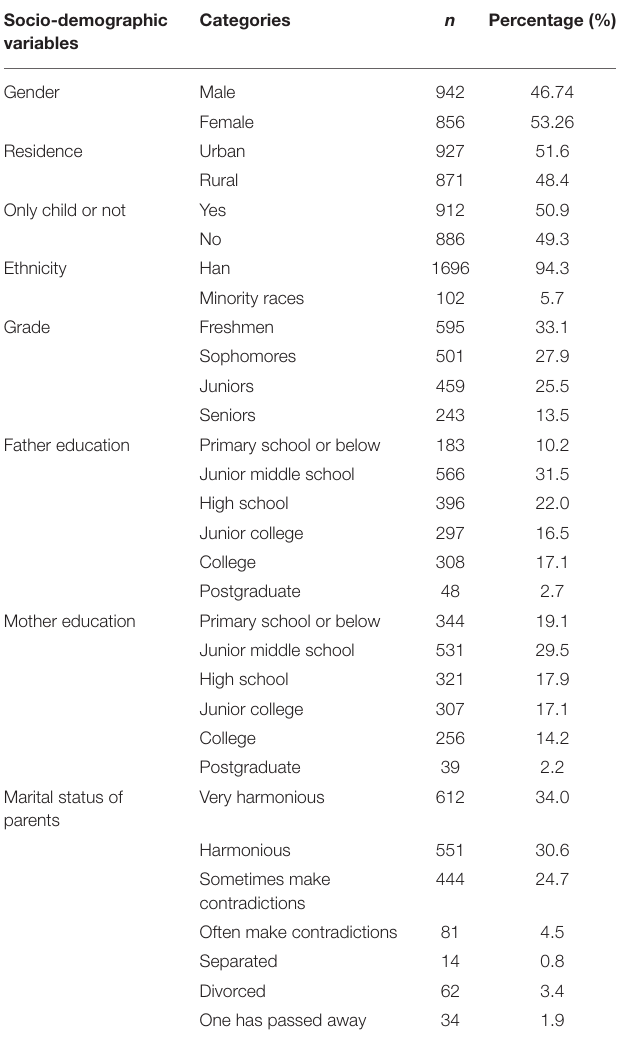
TABLE 1 | Socio-demographic information of the participants ( n =